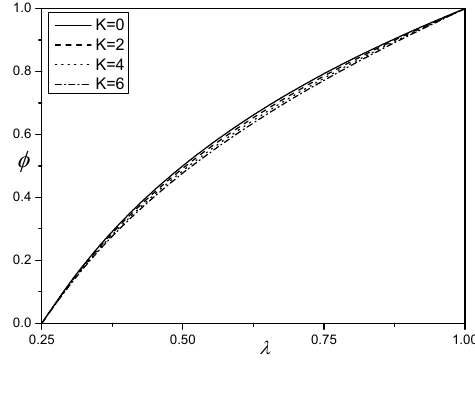
Fig. 17 Chemical reaction effect on φ ( λ